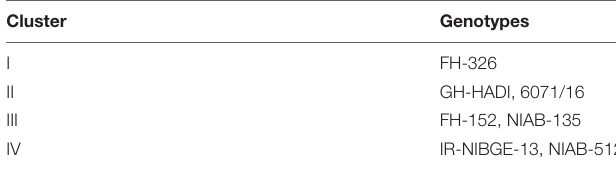
TABLE 18 | Distribution of cotton genotypes in different clusters.